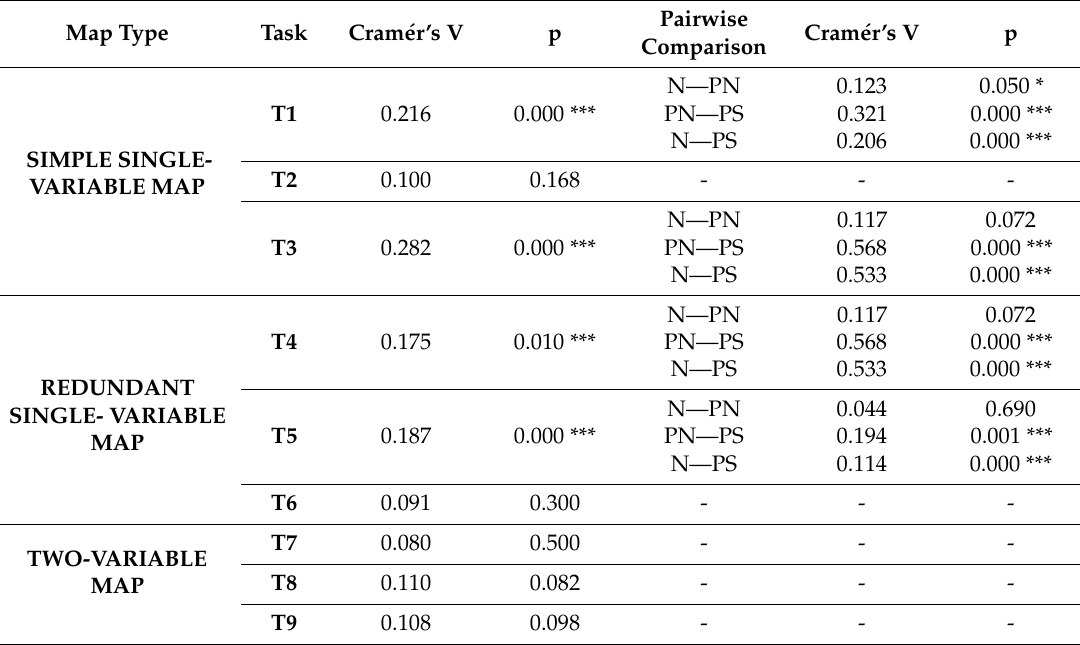
Table 6. Method and the task’s di ffi culty